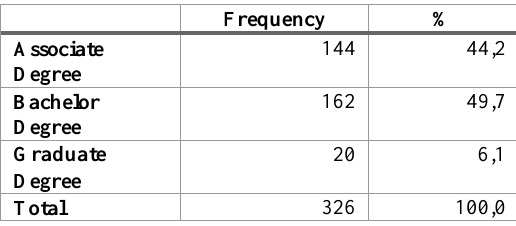
Table 10: Findings on Education Level